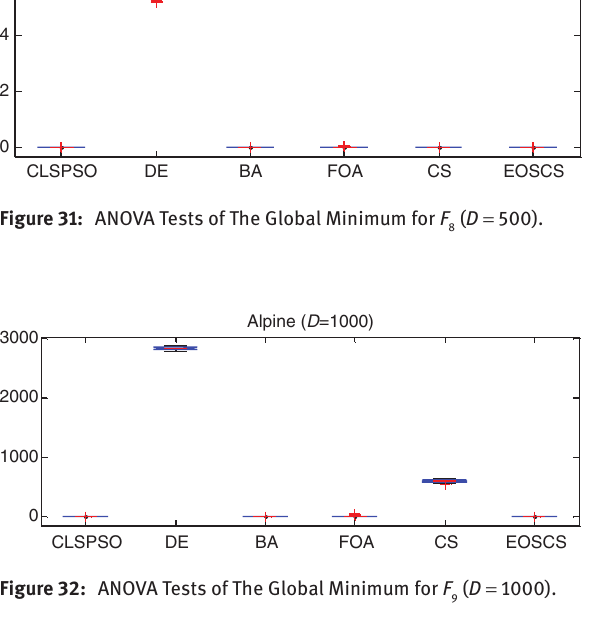
Figure 32: ANOVA Tests of The Global Minimum for F